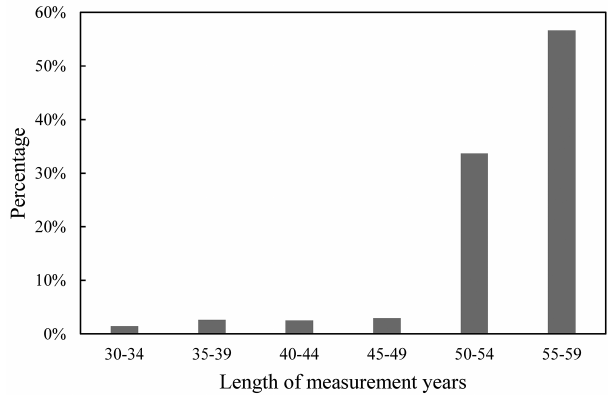
Figure 2. Percentage of weather stations with different measure- ment